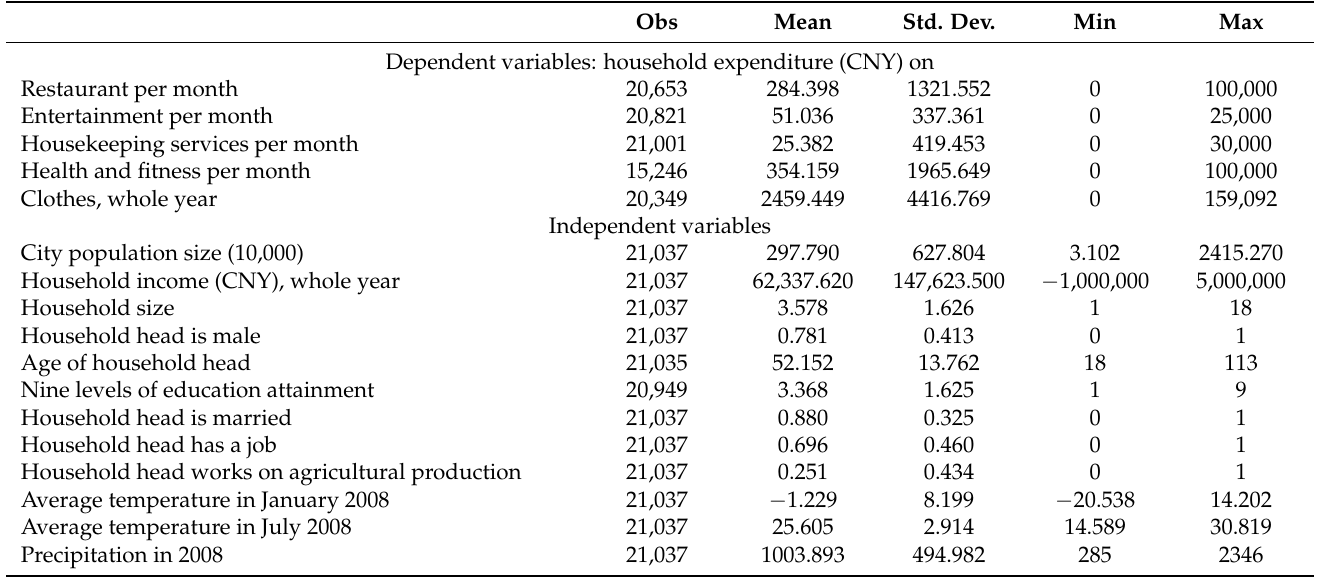
Table 1. Descriptive statistics.